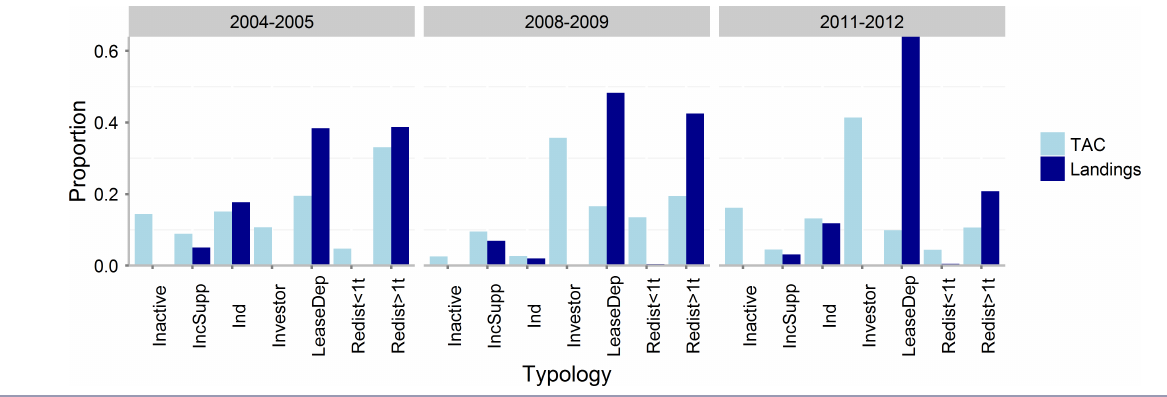
Fig. 6 . Proportional coral trout (CT) quota ownership and landings at the group level. Ownership presented as a proportion of the CT total allowable catch (TAC), landings as a proportion of total CT landings, for each year